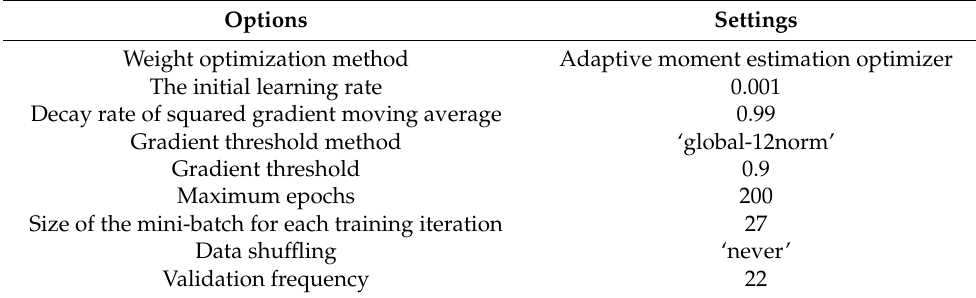
Table 1. Options for the training process used for cross-validation.